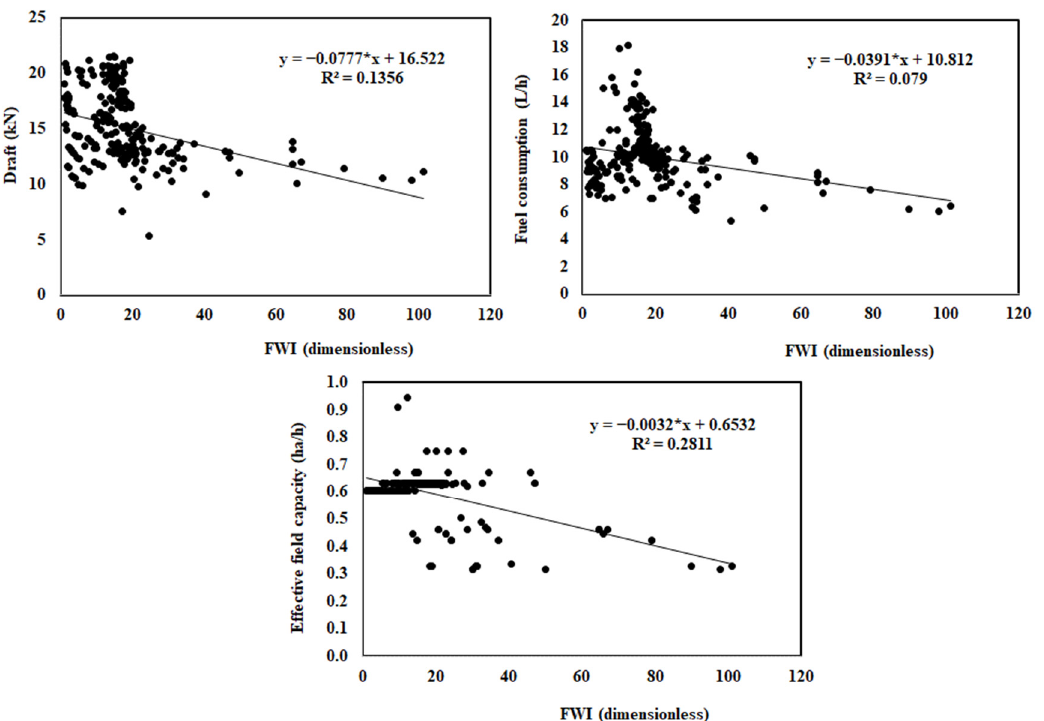
Figure 1. The correlation between the field-working index (FWI) and the performance attributes of draft, fuel consumption, and effective field capacity during soil-tillage operation.